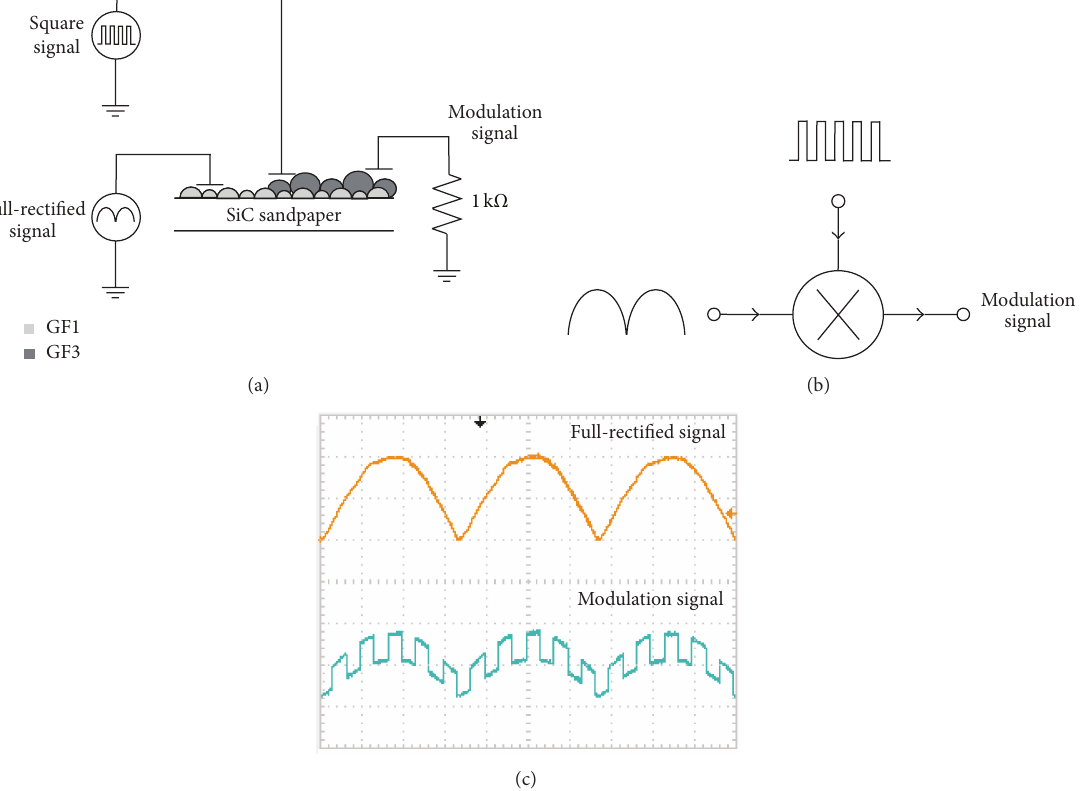
Figure 6: (a) Practical circuit implemented for modulation of a signal. (b) Mathematical function of a modulation process. (c) Modulation of a signal when a full-rectified signal was